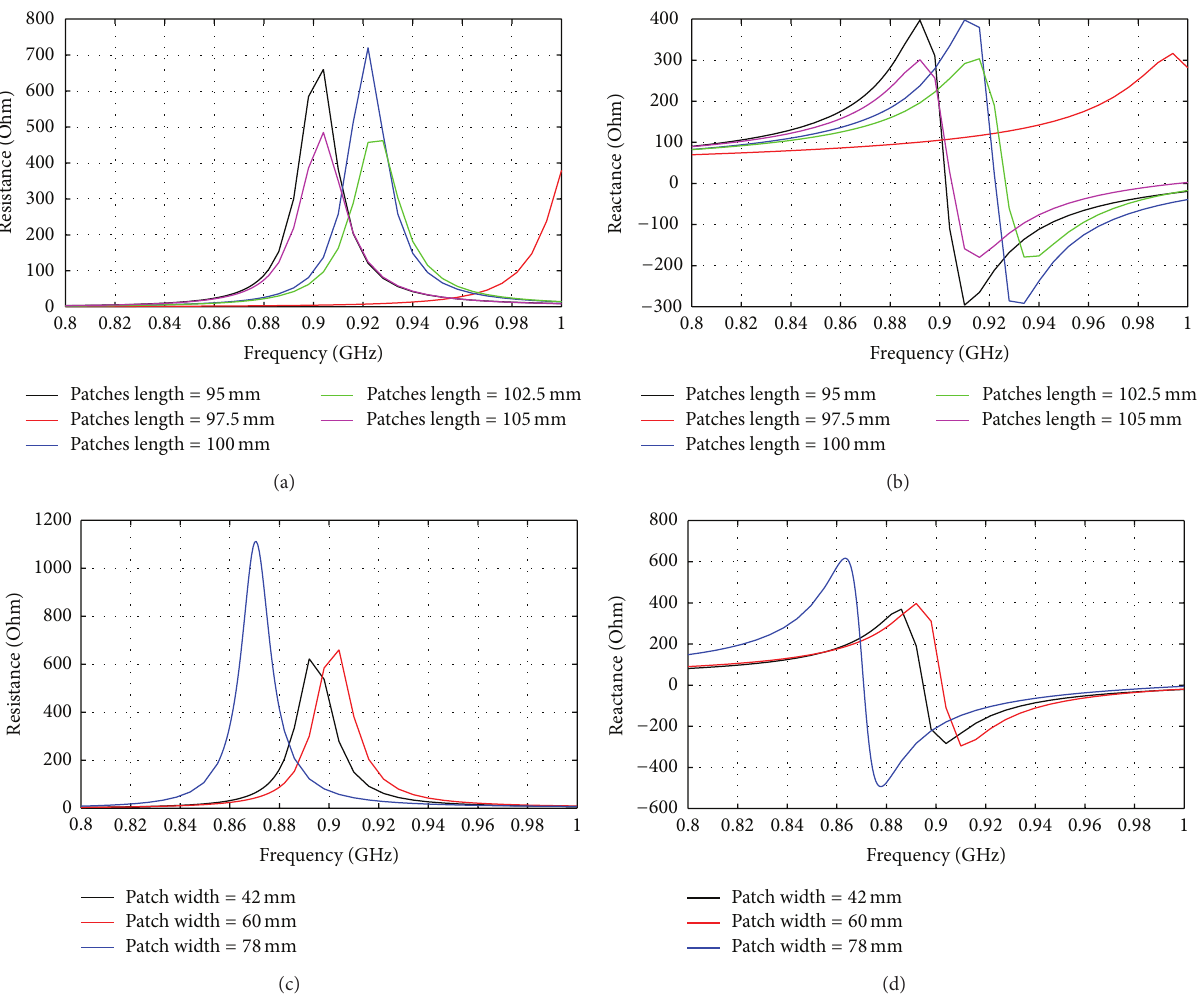
Figure 11: Tuning the (a) real and (b) imaginary parts of the input impedance by varying the patch length, and the same ((c) and (d)) for patch